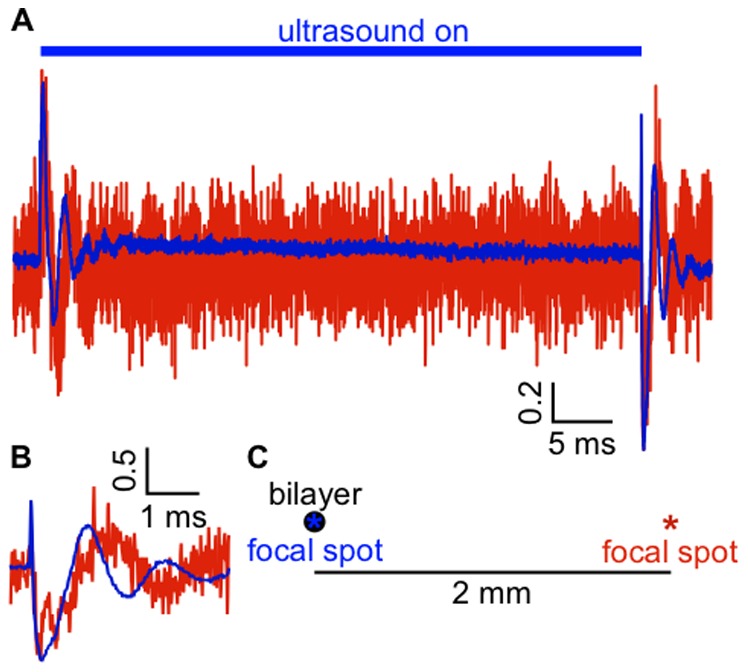
Maximal current response requires alignment of the bilayer and the ultrasound beam.
A. Current recorded from a POPE/POPG bilayer under voltage-clamp at −100 mV in response to a 50-ms, 13-W/cm2 ultrasound pulse from a 43-MHz focused transducer with the focal spot aligned on the bilayer (blue current trace) and with the focal spot moved 2 mm away from the bilayer in the x-y plane (red current trace). The currents are normalized to the peak inward current and the baseline currents have been subtracted. The current scale bar is in normalized units. The peak positive and negative currents were 147 and −157 pA with the focal spot centered on the bilayer, and 15 and −13.7 with the focal spot translated 2 mm in the x-y plane. The capacitance of the bilayer was 153 pF. The currents are the average of 10 ultrasound applications. Mean peak positive and negative currents, relative to the peak current with the bilayer and ultrasound beam aligned, for the On and Off responses (respectively) after moving the transducer were 8.9±0.1% and 9.1±0.1% (mean ± SE, n = 7). B. The Off current response from A. on an expanded time scale. C. Approximate scale drawing indicating the position of the focal spot for the two current traces.